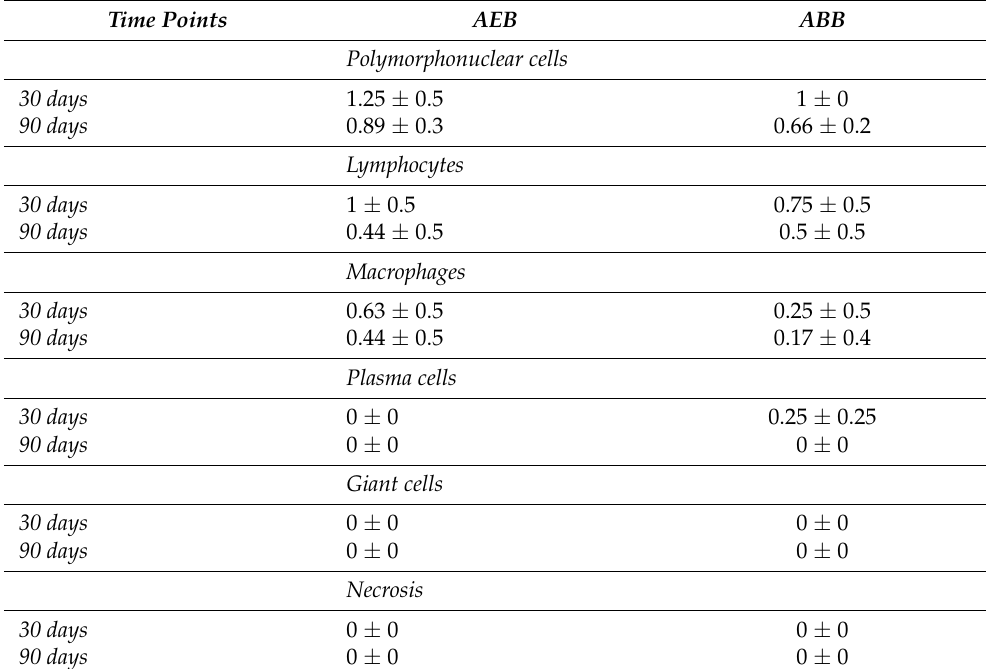
Table 2. Average histological scores of inflammatory data in AEB and ABB specimens.